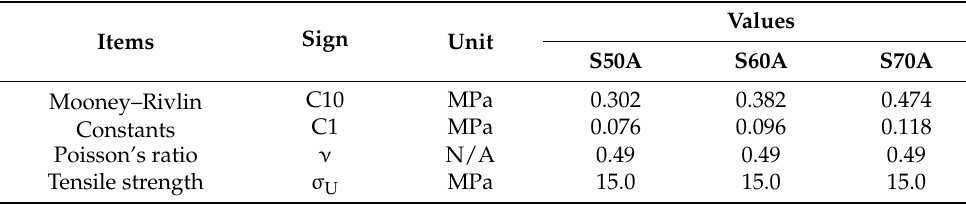
Table 9. Mechanical properties for an elastomer according to shore